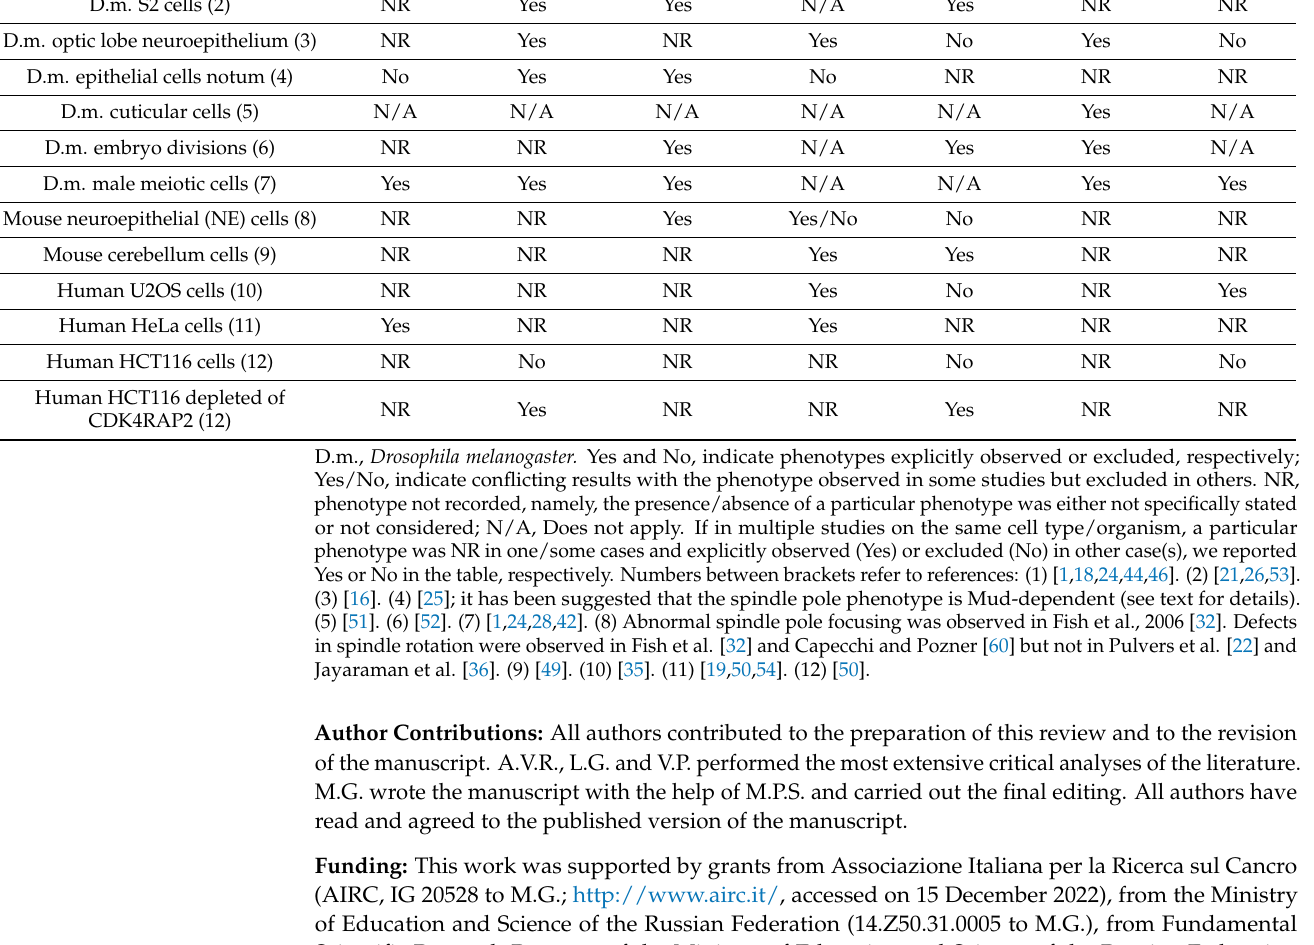
Organism/Cell Type with Asp/ASPM